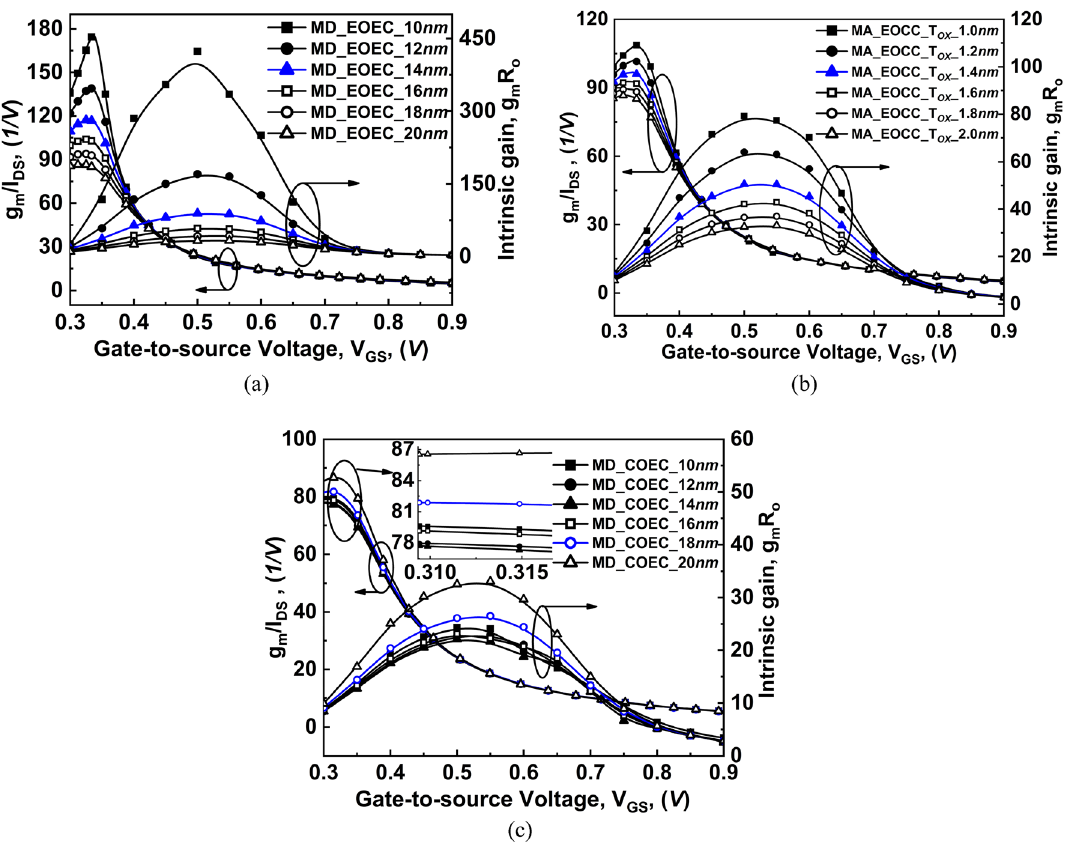
Figure 13. Comparison of variation of transconductance generation factor and intrinsic gain as a function of gate voltage at V DS = 0.3 V of COCC structure with: ( a ) EOEC, ( b ) EOCC, and ( c ) COEC